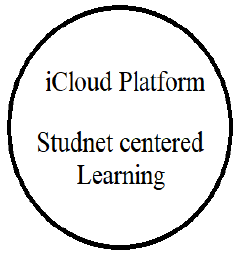
Figure 3. Process of iCloud